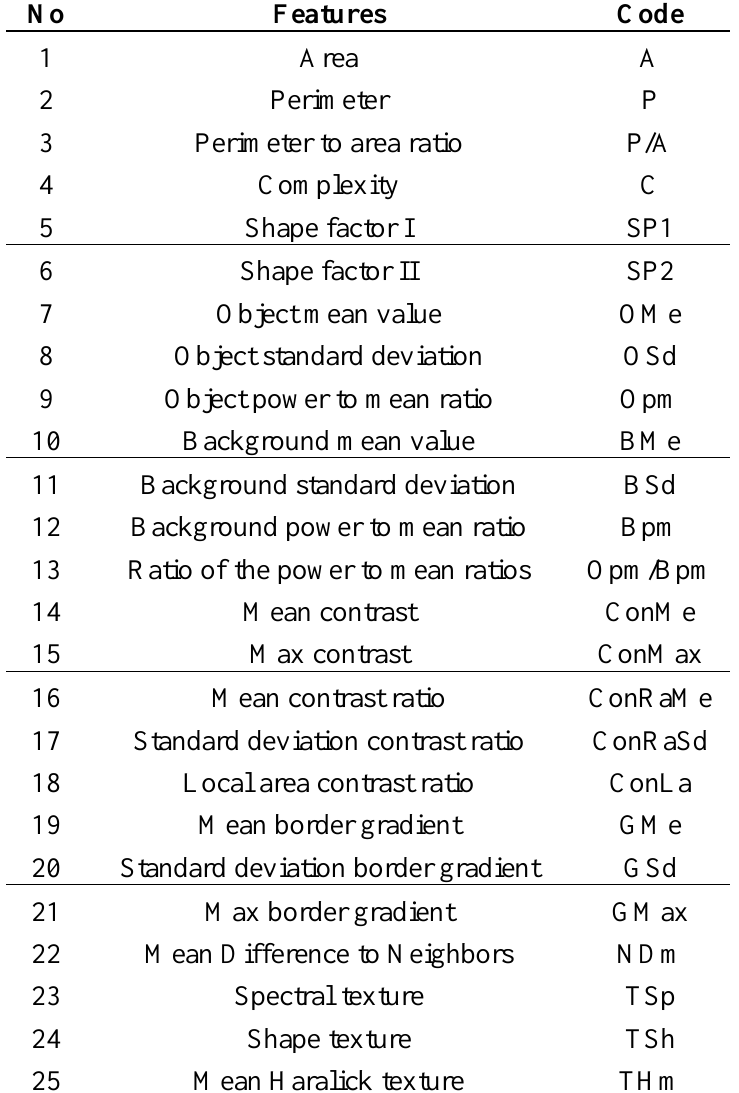
Table 3. Commonly features used (adapted from Stathakis et al.